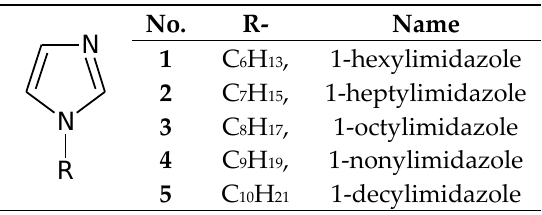
Figure 2. The 1-alkylimidazole molecule.